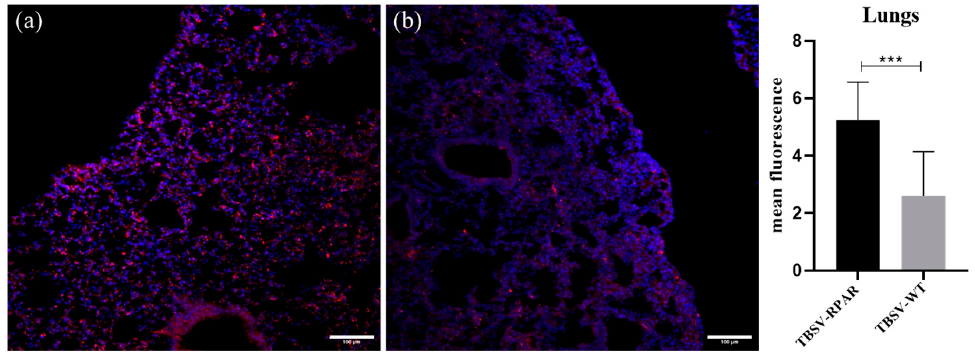
Figure 7. TBSV-RPAR accumulation in the pulmonary tissue following i.v. administration. Immunofluorescent localization of TBSV in lung sections of mice that received i.v. injection with ( a ) TBSV-RPAR and ( b ) TBSV-WT. Blue: DAPI (nuclei). Scale bars = 100 µm. TBSV fluorescence signal (pink) was quantified using ImageJ software and expressed as mean of fluorescence. Five randomly chosen fields from 3 different animals per group were analyzed. Data represent mean ± SD, *** p < 0.001 (Student’s t